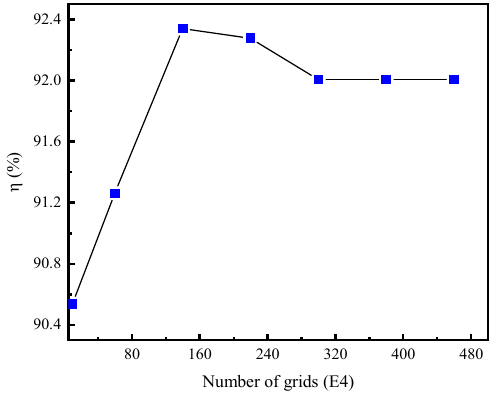
Figure 6. Robustness Analysis of Simulation Process. Table 2. Process parameters of simulation experiment .